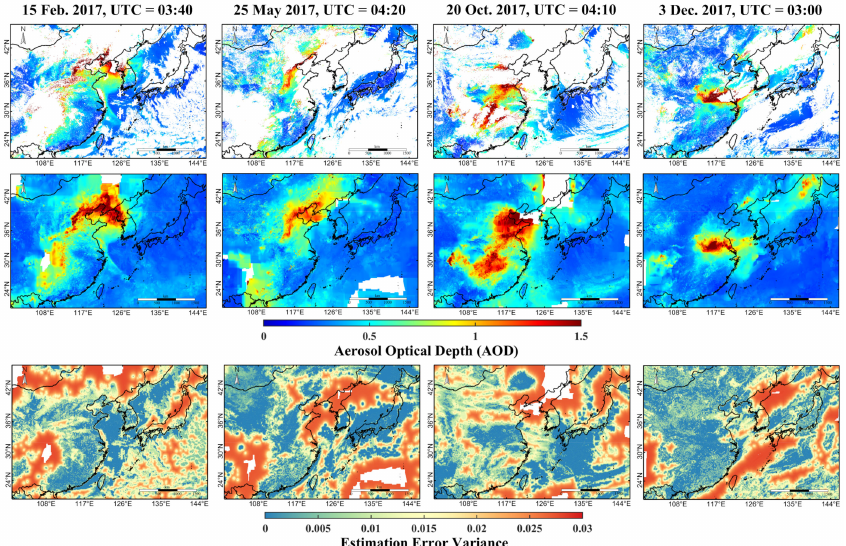
Figure 8. Maps of the original Himawari-8 AHI AOD (first line), merged AOD (second line), and estimation error variance (EEV) of the merged AOD data (third line) in the experimental region on 15 February, 25 May, 20 October, and 3 December of